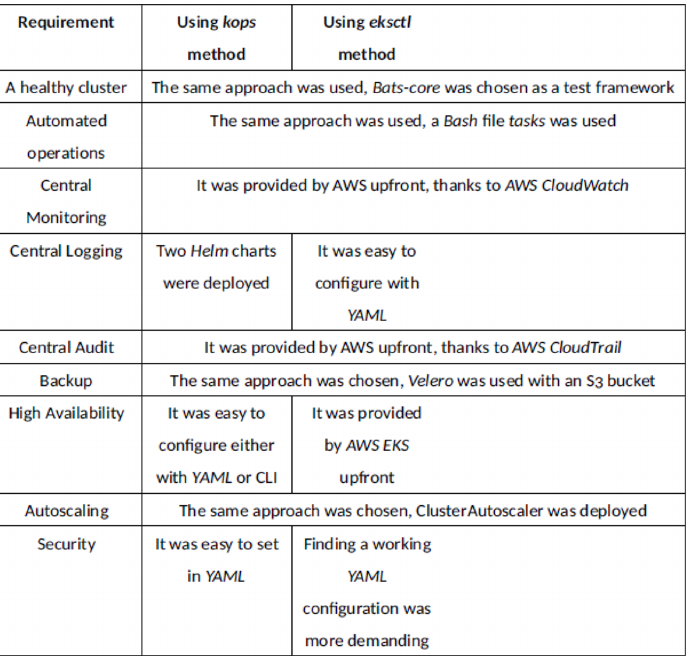
Figure 4. Comparison of how each production requirement was satisfied using kops and eksctl. Table 1. Time needed to run Kubernetes management operations using kops and eksctl